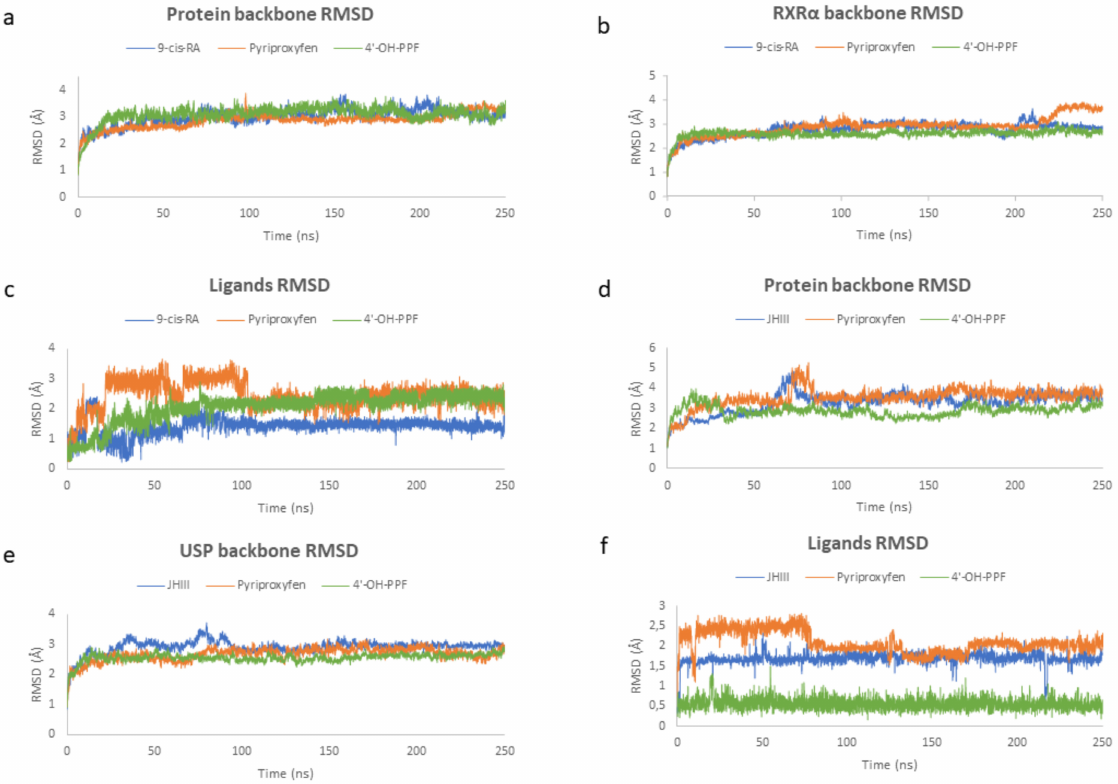
Figure 5. RMSD results graphics in Homo sapiens and Apis mellifera . RMSD of protein backbone of H. sapiens ( a ) and A. mellifera ( d ), RMSD of RXR α ( b ) and USP ( e ) monomer, and heavy atoms of the ligands of H. sapiens ( c ) and A. mellifera ( f